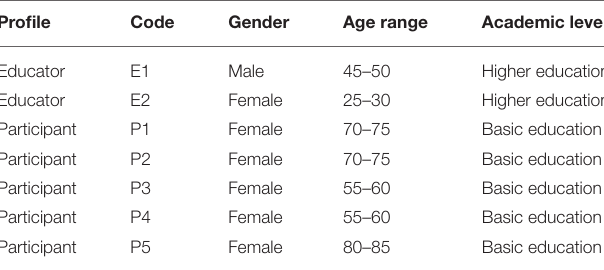
TABLE 1 | Participants’